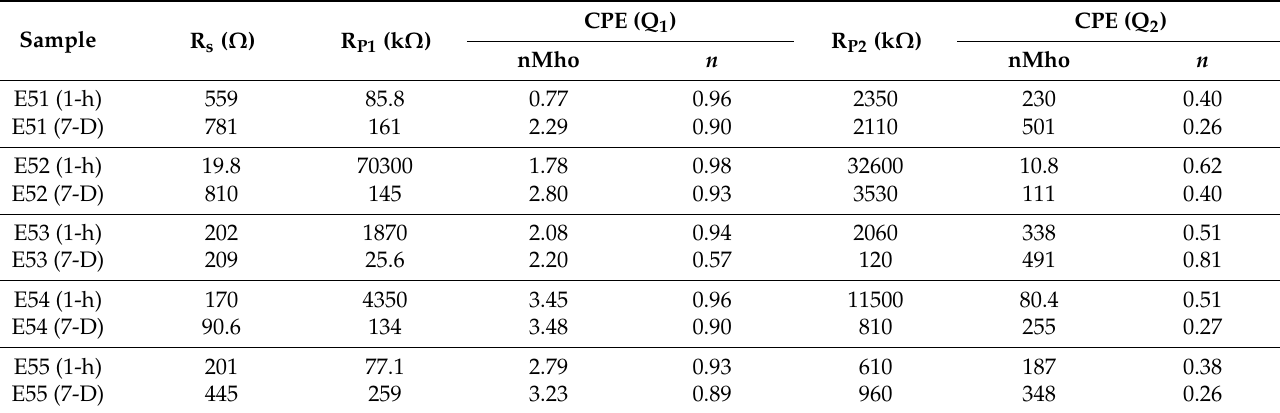
Figure 7. Equivalent circuit model used to fit the EIS data. Table 5. Obtained parameters after fitting samples to the 3.5% NaCl